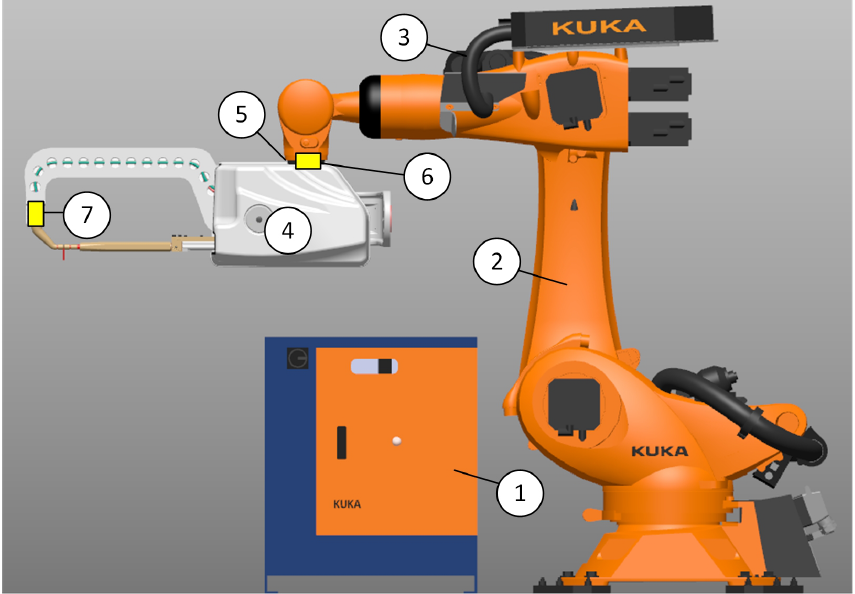
Figure 4. Elements of the test bench: 1—robot controller, 2—manipulator, 3—dress pack, 4—weld gun, 5—flange, 6—vMTi-680, 7—MTi-300.